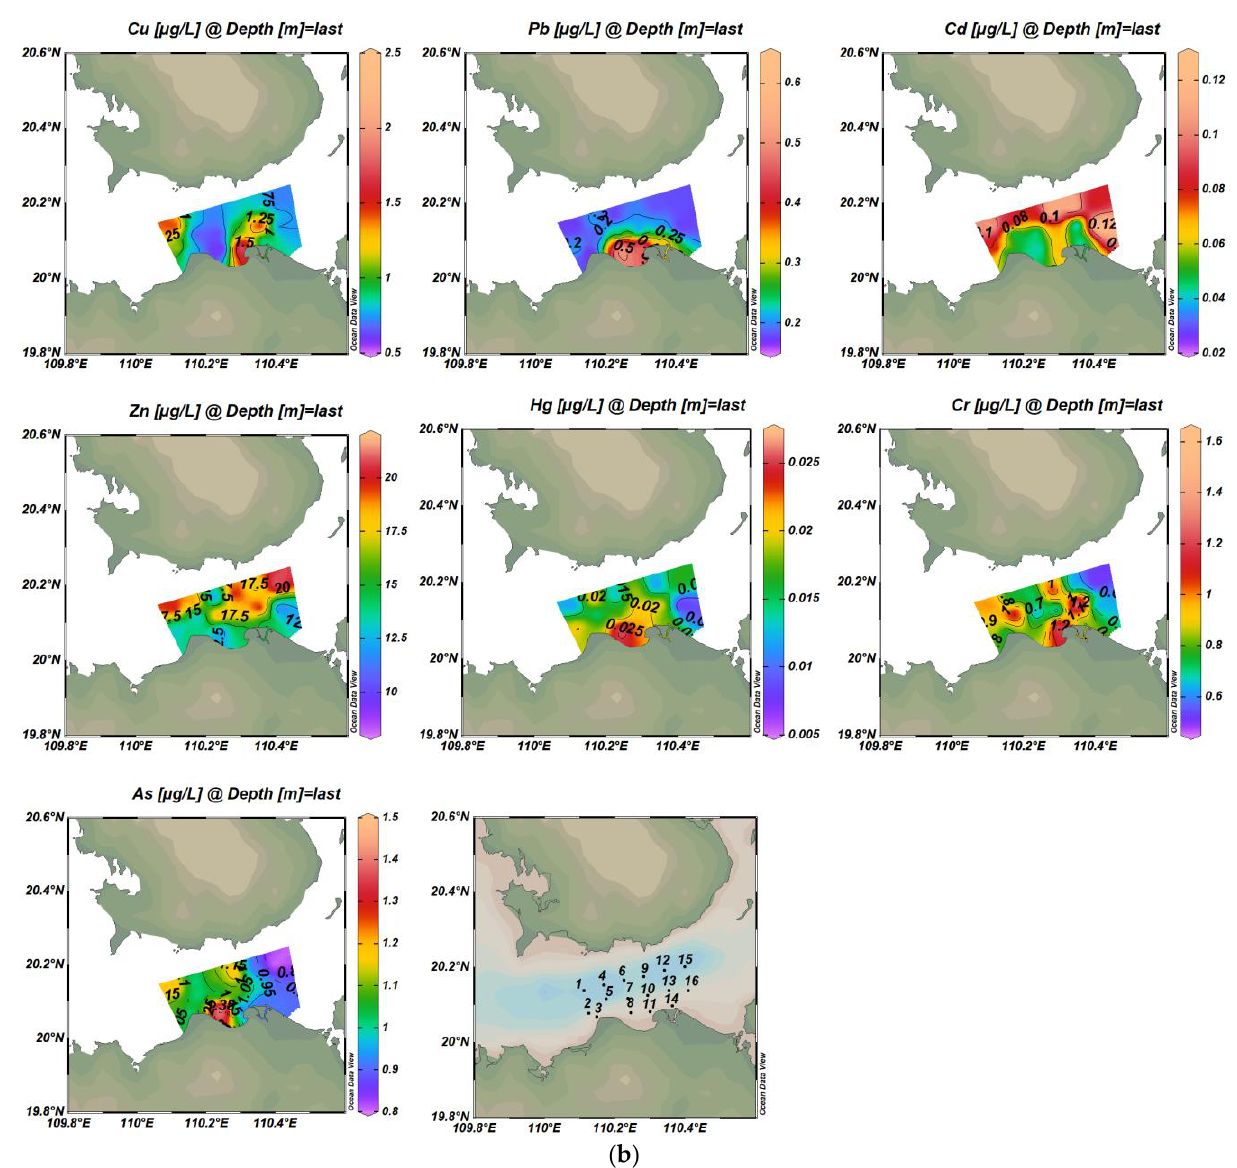
Figure 2. Spatial distribution of concentrations of seven trace metals in surface and bottom water bodies (( a ) is the surface layer; ( b ) is the bottom layer). Table 3. Correlation analysis between factors in surface water.